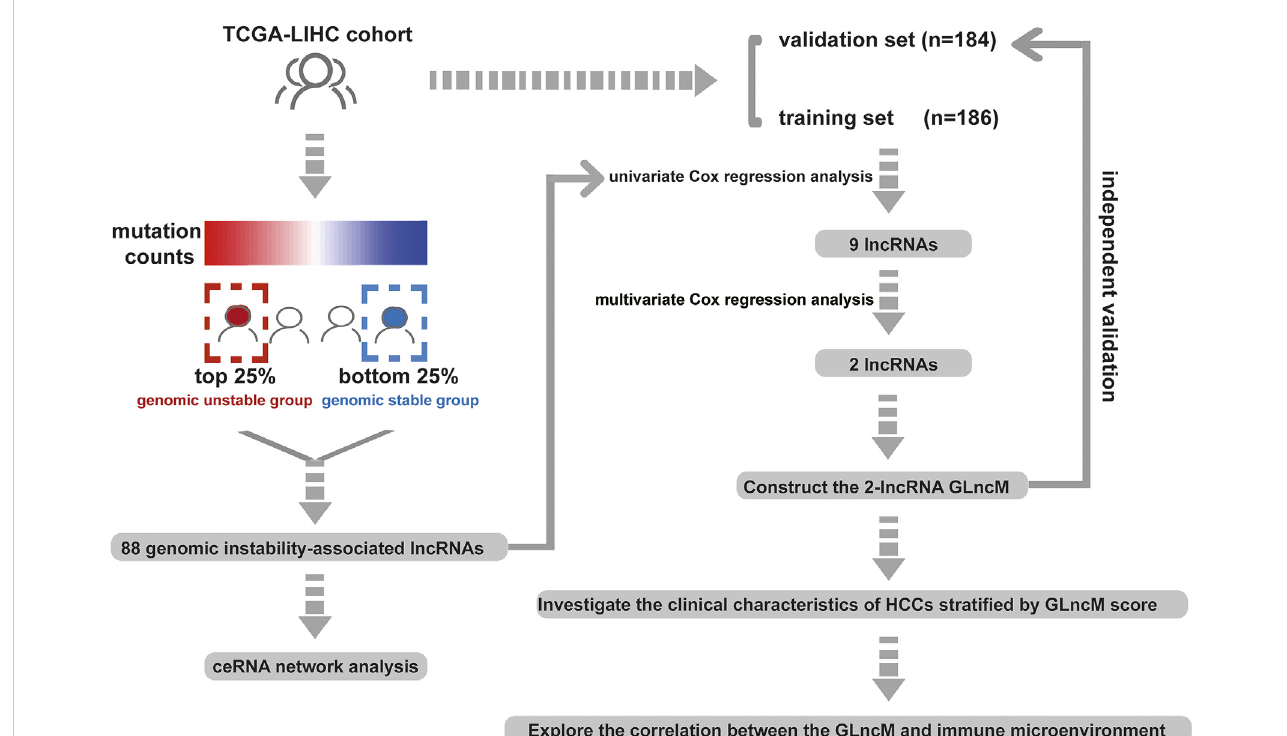
FIGURE 1 Work fl ow of this